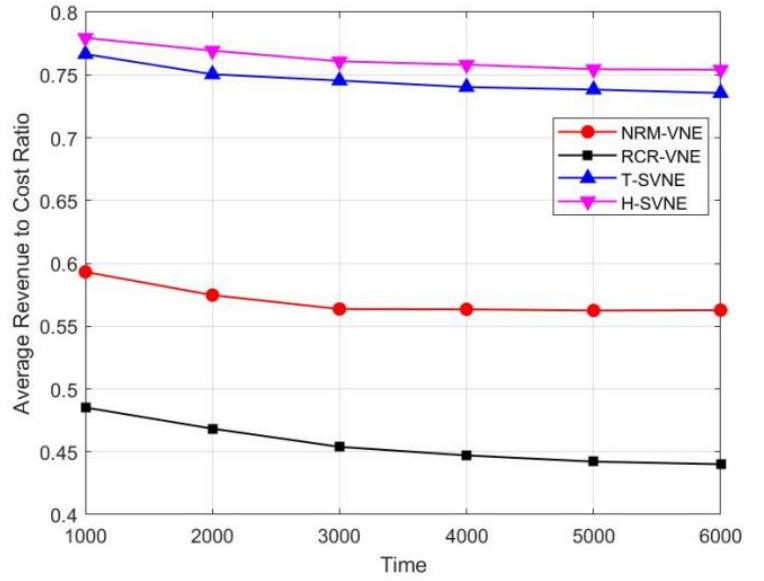
Figure 6. The average revenue to cost ratio.